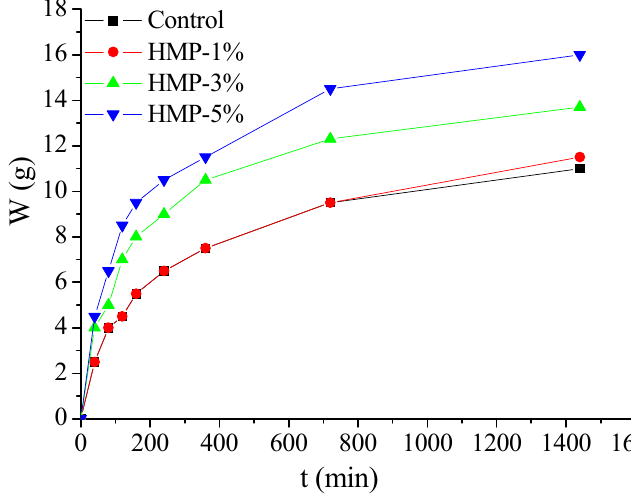
Figure 7. ISA test results of the HMP mortars